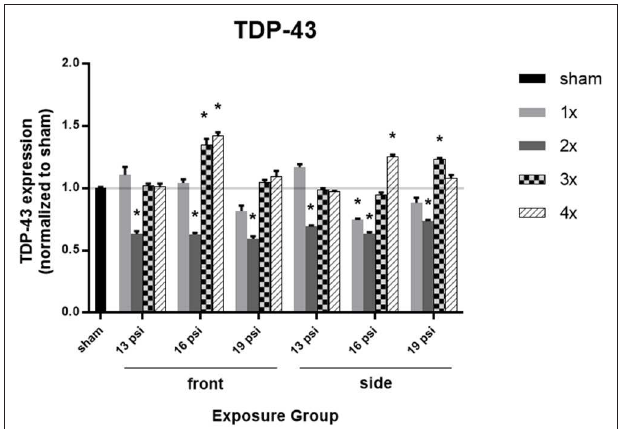
FIGURE 6 | Quantification of Piezo2 expression measured by Western blot. Results presented as blast intensity for each orientation (front vs. side). Values normalized to sham. Statistical significance compared to sham: * p < 0.05 (Significance values in Supplemental Table 5 ). Data is expressed as mean ± SEM, normalized to sham. Representative Westerns shown in Supplemental Figure 2